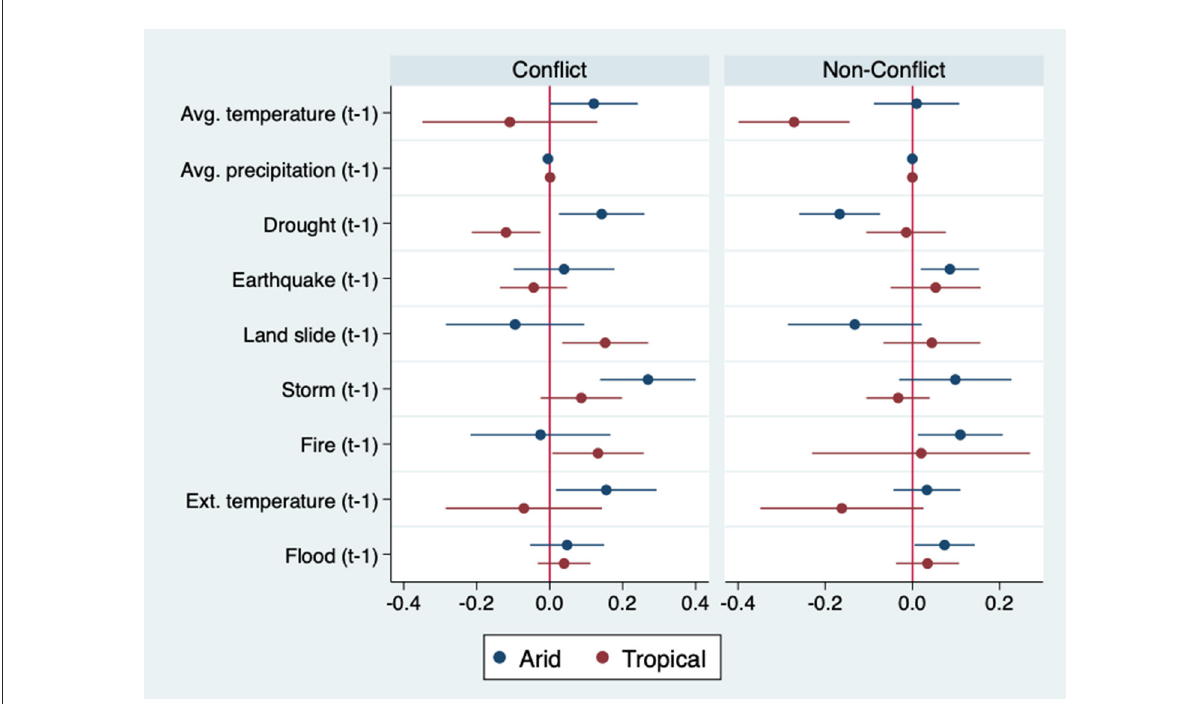
FIGURE1 Coefficients’ plot of the climatic variables, for high and low conflict levels, by arid and tropical